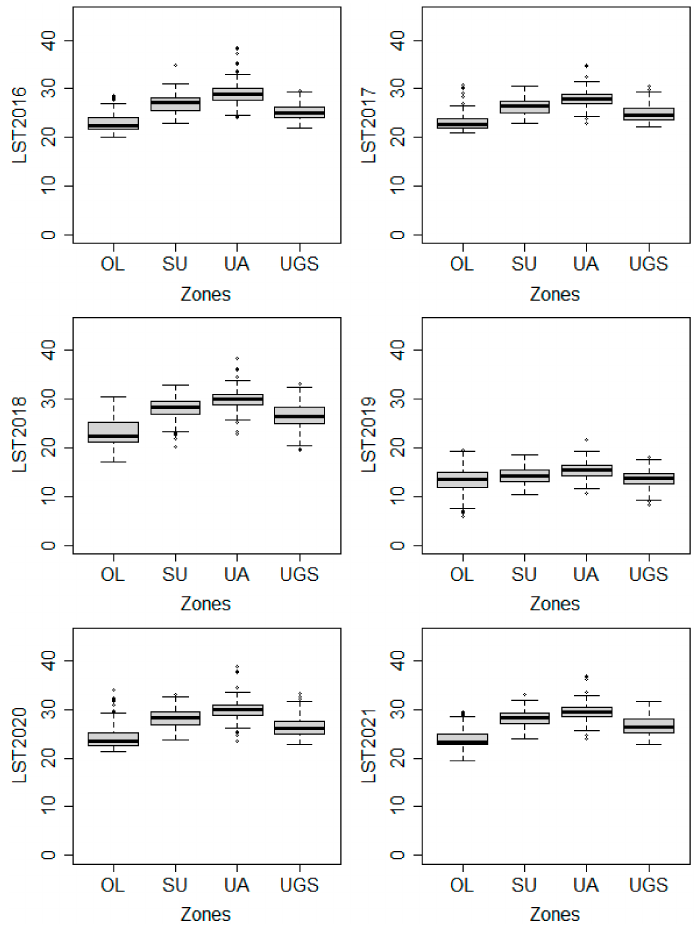
Figure 9. Comparison of boxplots of LST distributions for random points within the analyzed zones in the years 2016–2021. Boxes indicate median and quartiles, and whiskers extend to the most extreme data points, not considering outliers (defined by 1.5 interquartile ranges). OL—open land, UA—dense urban area, SU—discontinuous urban area, UGS—urban green spaces.